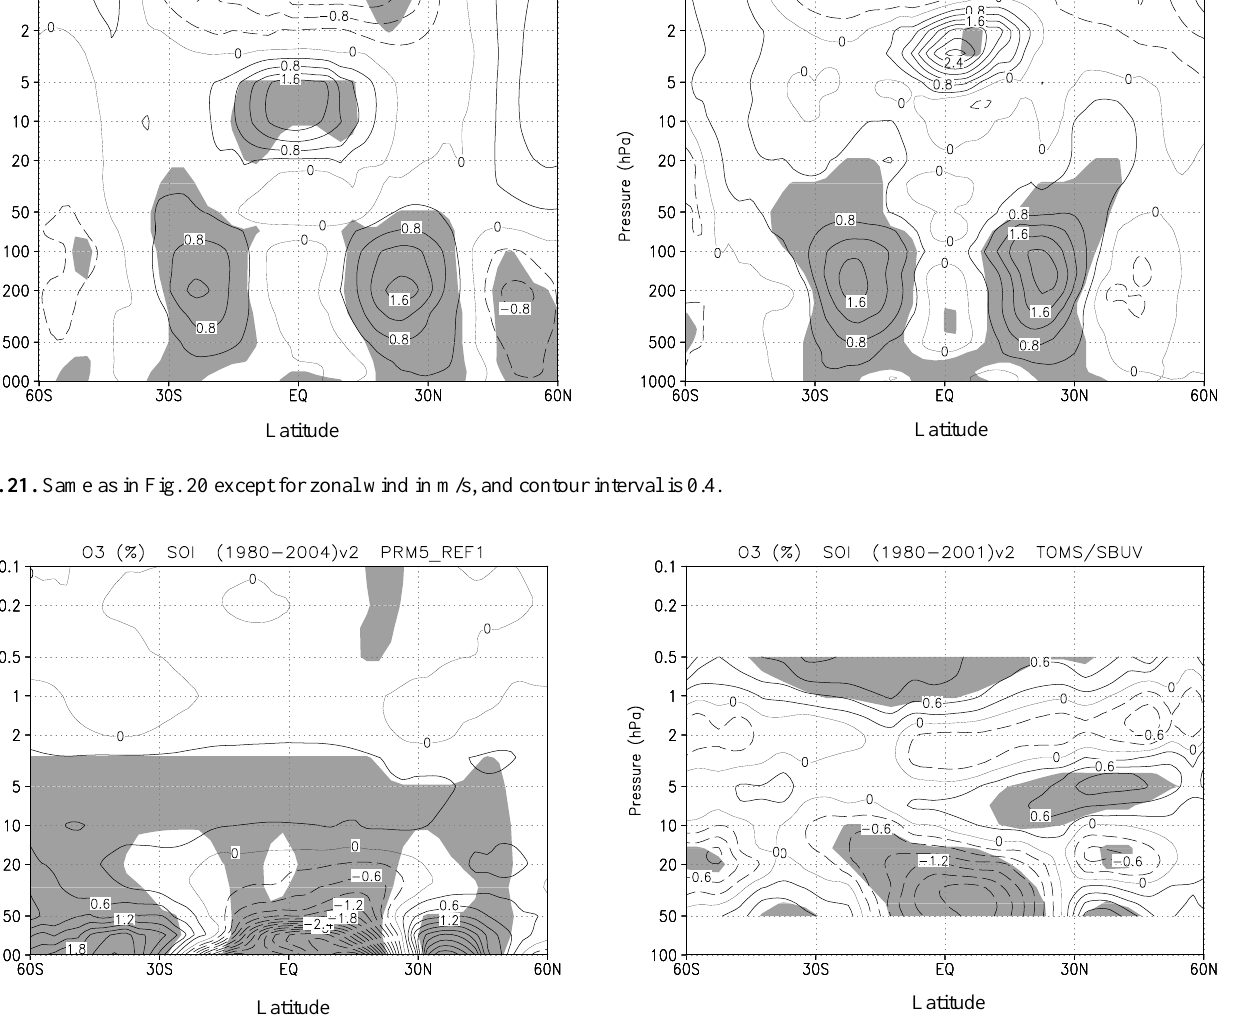
Fig. 22 Same as in Fig. 20 except for ozone (%) and TOMS/SBUV (left panel). Contour interval is 0.3.